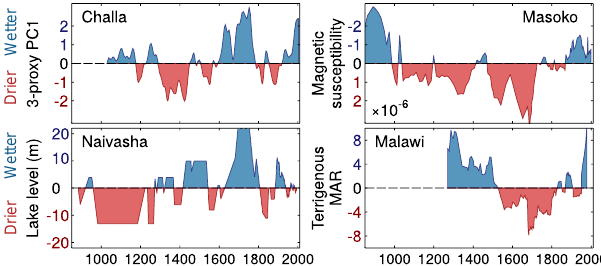
Figure 5. Lake-based moisture-balance reconstructions used in this study; references with details on the proxies are provided in Sect. 2.2. Ordinate axes for each proxy are oriented such that wetter (drier) hydroclimate conditions point upward